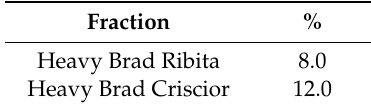
Table 1. Heavy fractions separated from the flow table.